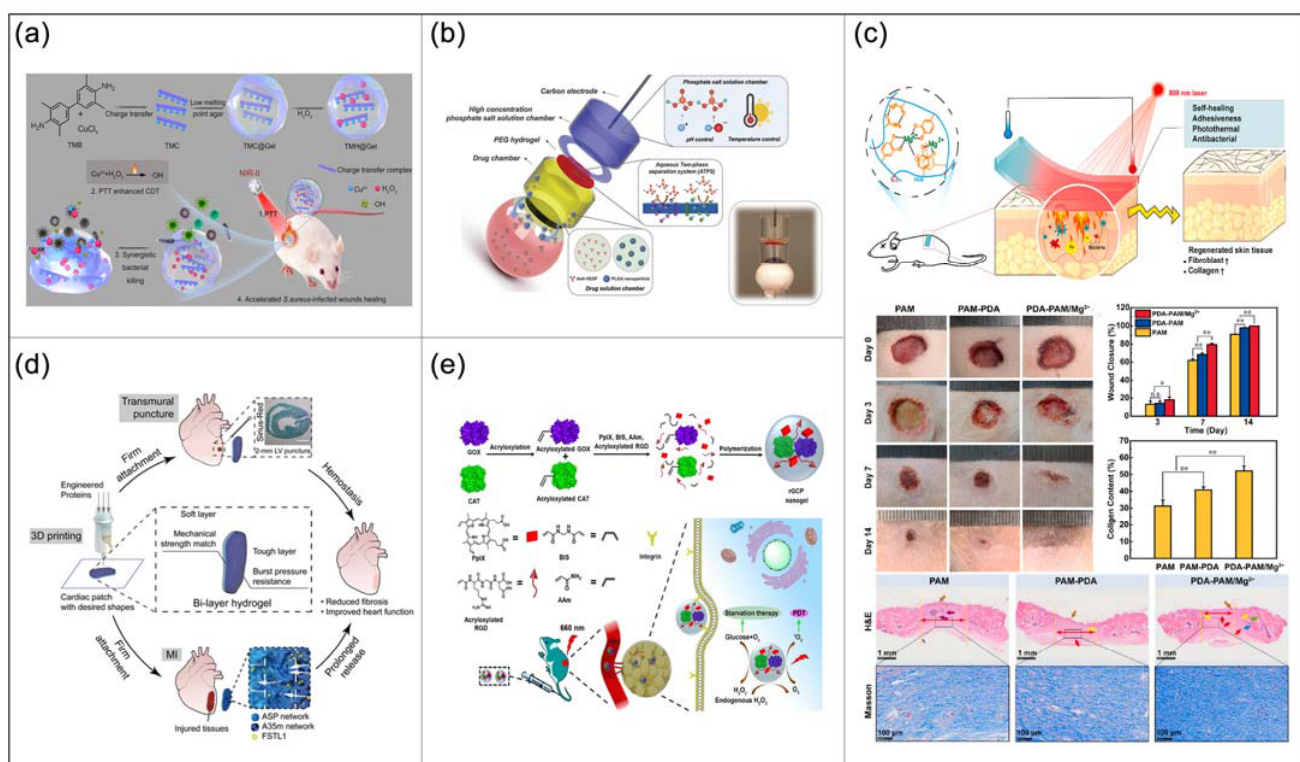
Figure 4. Applications of CHs in drug delivery systems and other biomedical fields. ( a ) Schematic illustration of the preparation of TMH@Gel Complex and the mechanism of TMH@Gel for accelerated wounds healing. ( b ) Schematic of a high-intensity iontophoresis device for intraocular delivery of macromolecules and nanoparticles. ( c ) Schematic illustration for the mechanism and application of PDA-PAM/Mg 2+ hydrogel in wound healing in a full-thickness defect model; Wound healing effects in vivo of the hydrogels. ( d ) Schematic diagram of the working principle of the minimally invasive cardiac patch. ( e ) The synthetic route of rGCP nanogels and the application in amplified synergistic cancer therapy by combining starvation and photodynamic therapy.